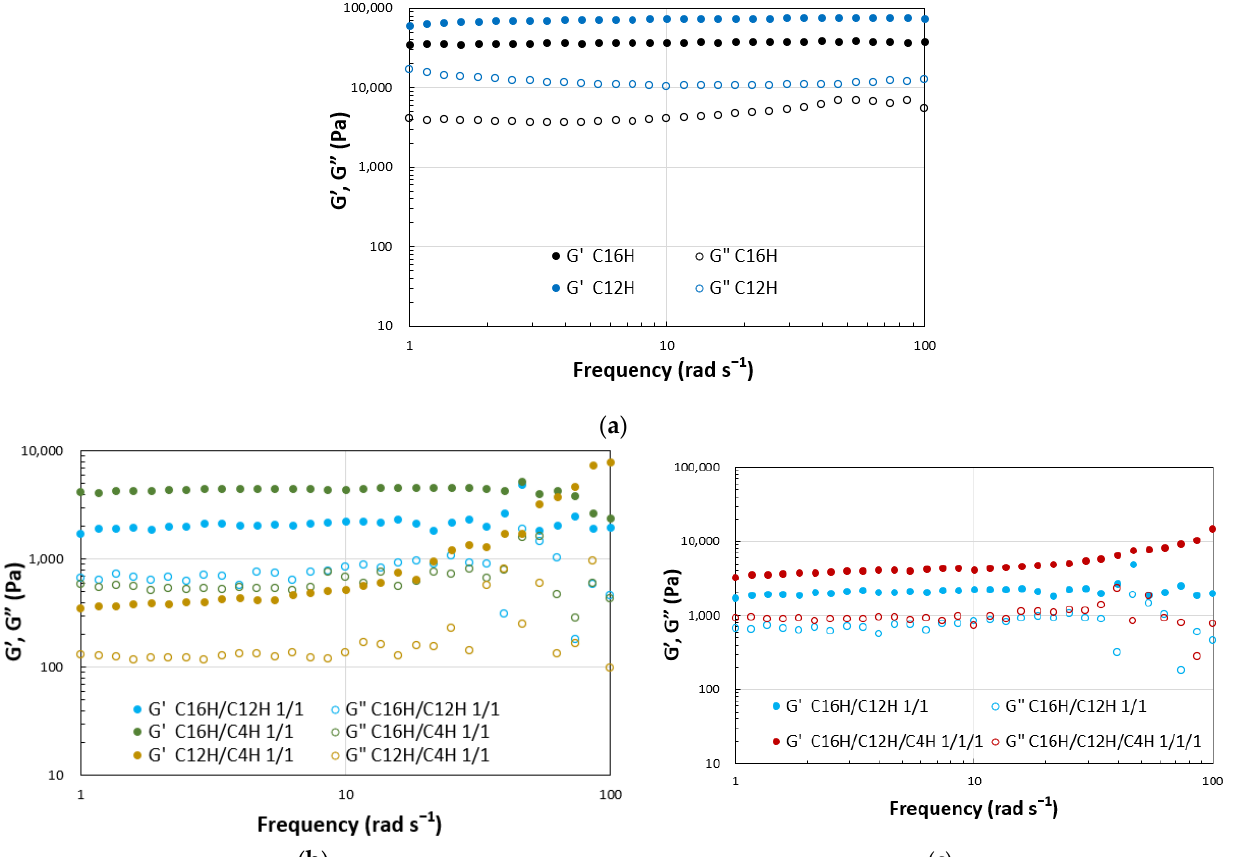
Figure 4. Dynamic rheological properties of the mixed molecular squalane organogels (3.0 wt.%) on frequency sweep; ( a ) single gels, ( b ) binary gels, and ( c ) tertiary gels with C16H/C12H 1/1 gel as a reference.